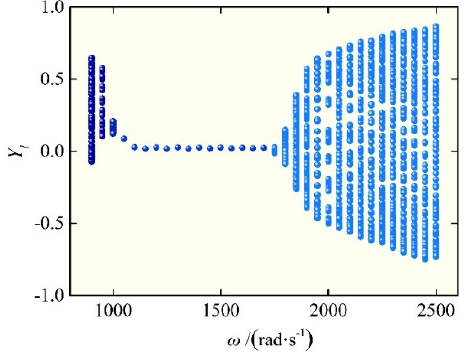
Figure 5. Bifurcation diagram of the rod–fastened rotor at ω = 900~2500 rad/s.